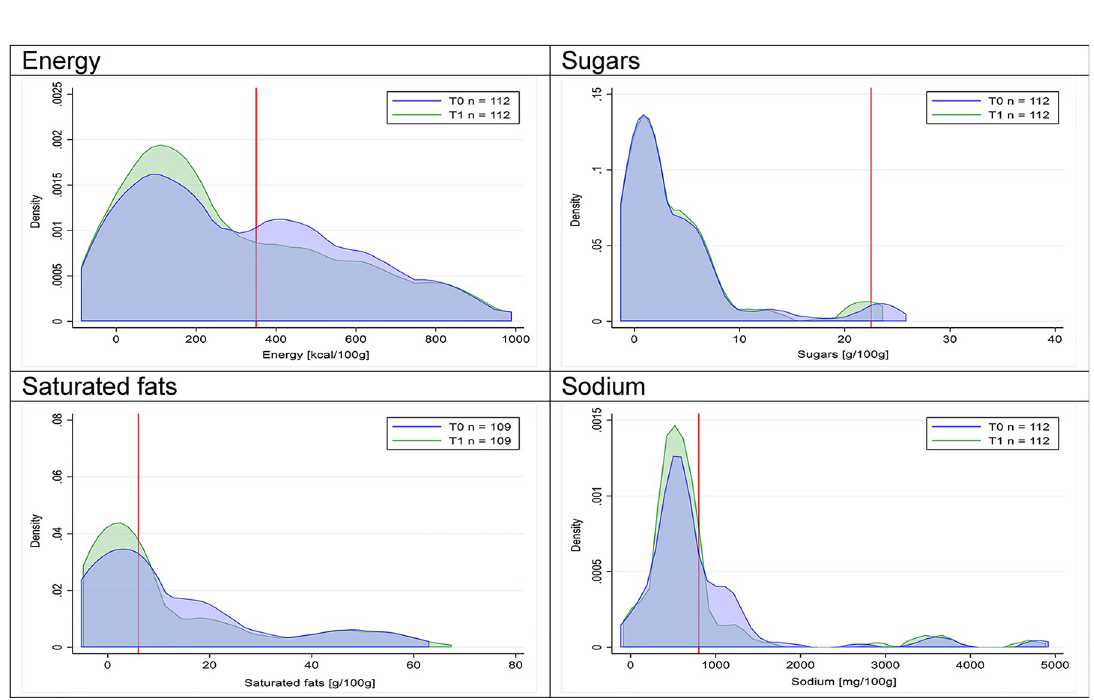
Fig 28. Density curves for the amount of energy and nutrients of concern in savory spreads, longitudinal subsample. The blue line represents the distribution in T0 (preimplementation), the green line represents the distribution in T1 (postimplementation), and the red line represents the cutoff for the amount of energy or nutrients of